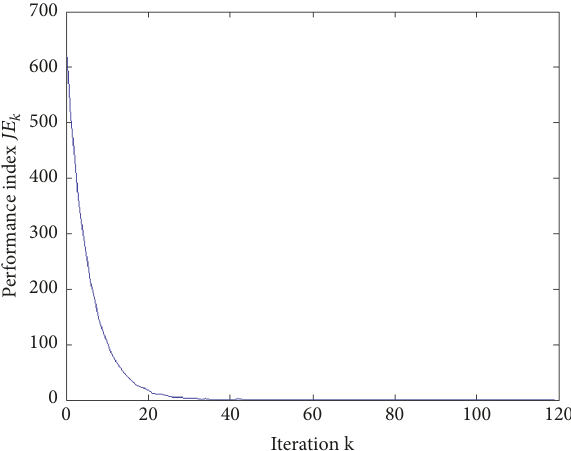
Figure 2: The performance index 𝐽𝐸 𝑘 at different iterations by using the proposed P-type ILC law (8).